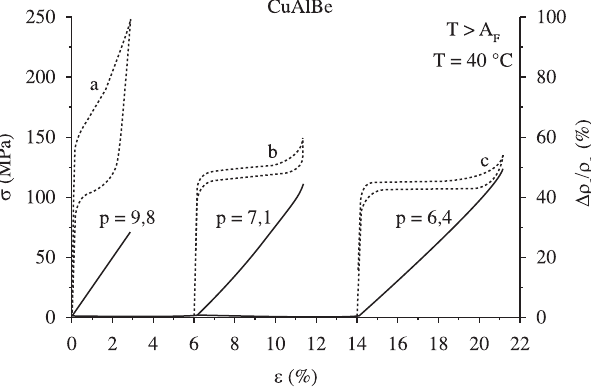
Figure 7. Superelastic tests in the CAB12 tensile samples with different crystallographic orientations (Cu-Al-Be